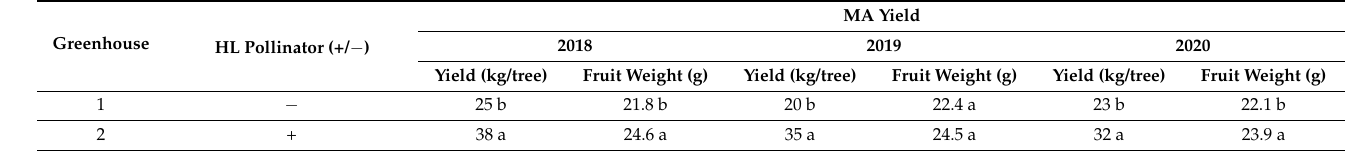
Table 3. The effect of the pollinizer HL on the yield and fruit weight of MA trees in the greenhouse, Orchard Farm 2018–2020.